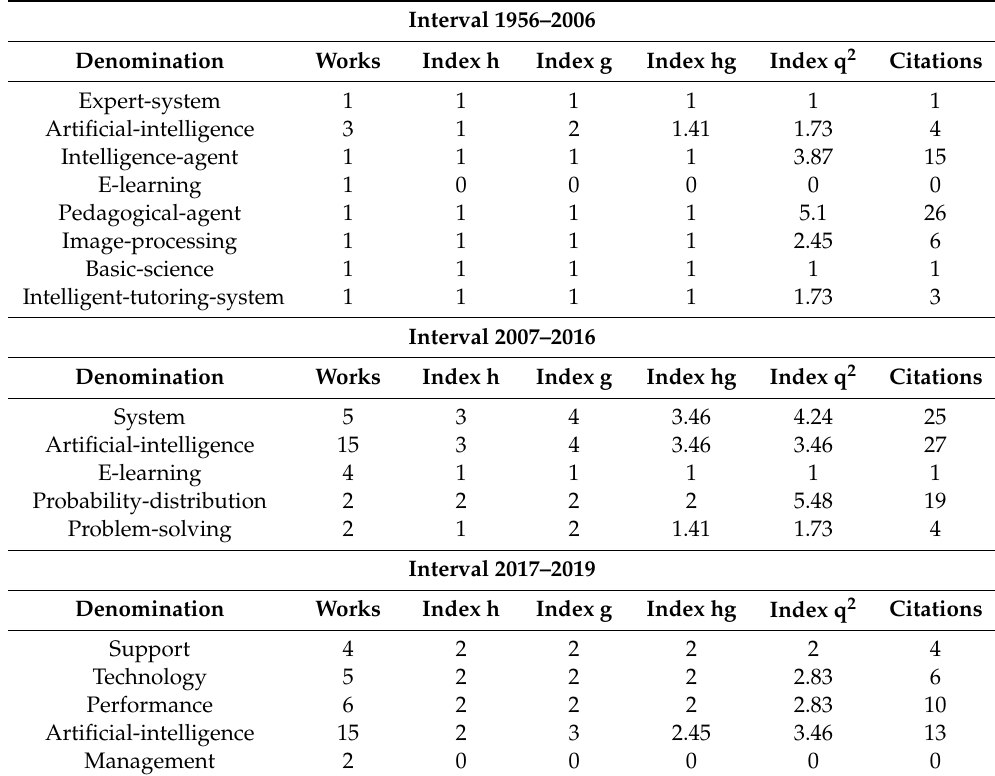
Table 10. Thematic performance in